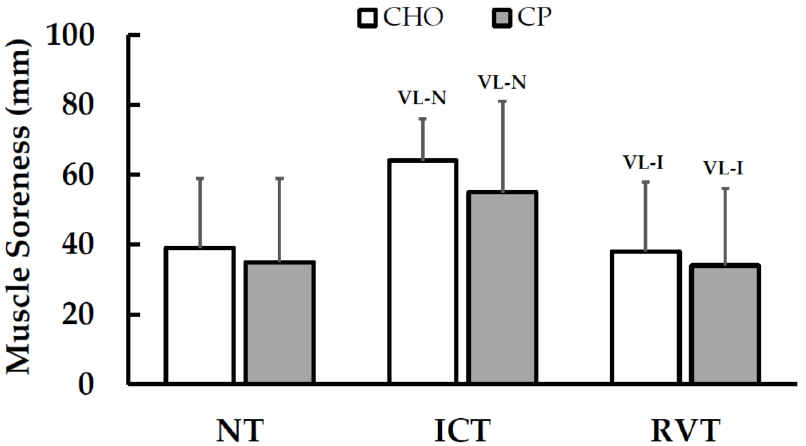
Figure 5. Effects of Training Periods and Nutritional Supplementation on Muscle Soreness (Mean